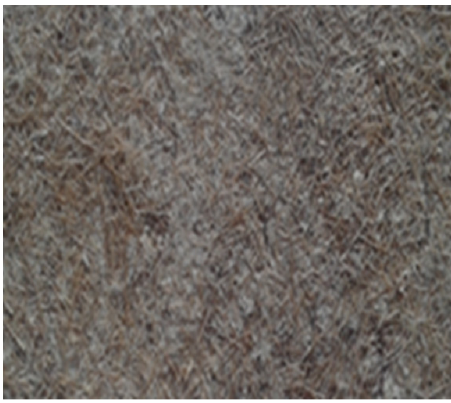
Figure 2. Wet-laid nonwoven Posidonia fiber.